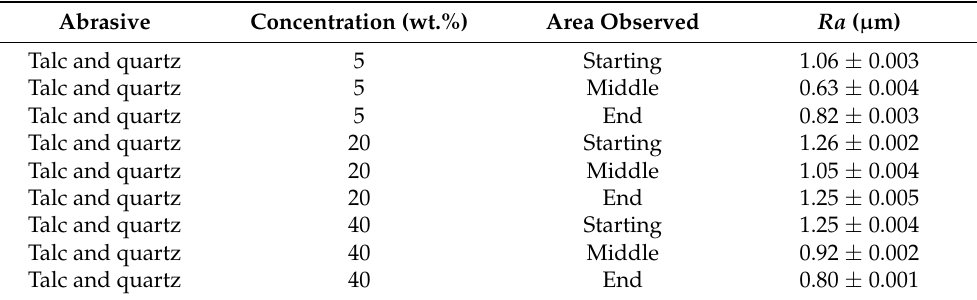
Table 8. Roughness of AISI 4145H steel after being abraded by slurry with the mixed abrasives of talc and